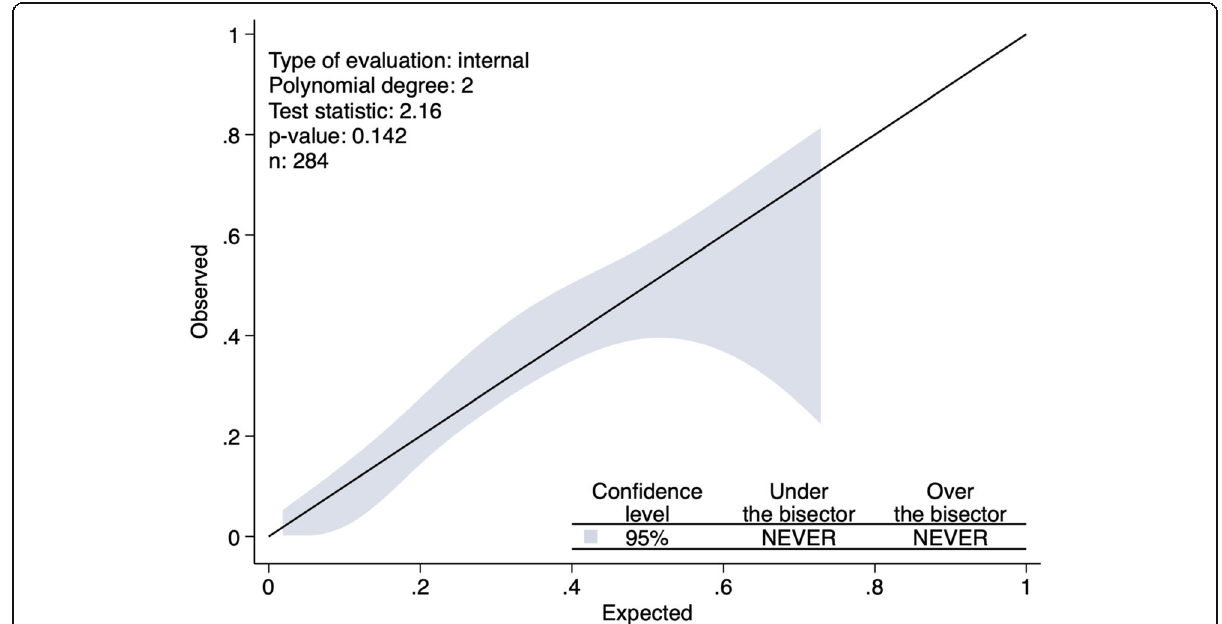
Fig. 2 Calibration curve for predictive model for live birth following TESE-ICSI. Relationship between the calculated and observed live